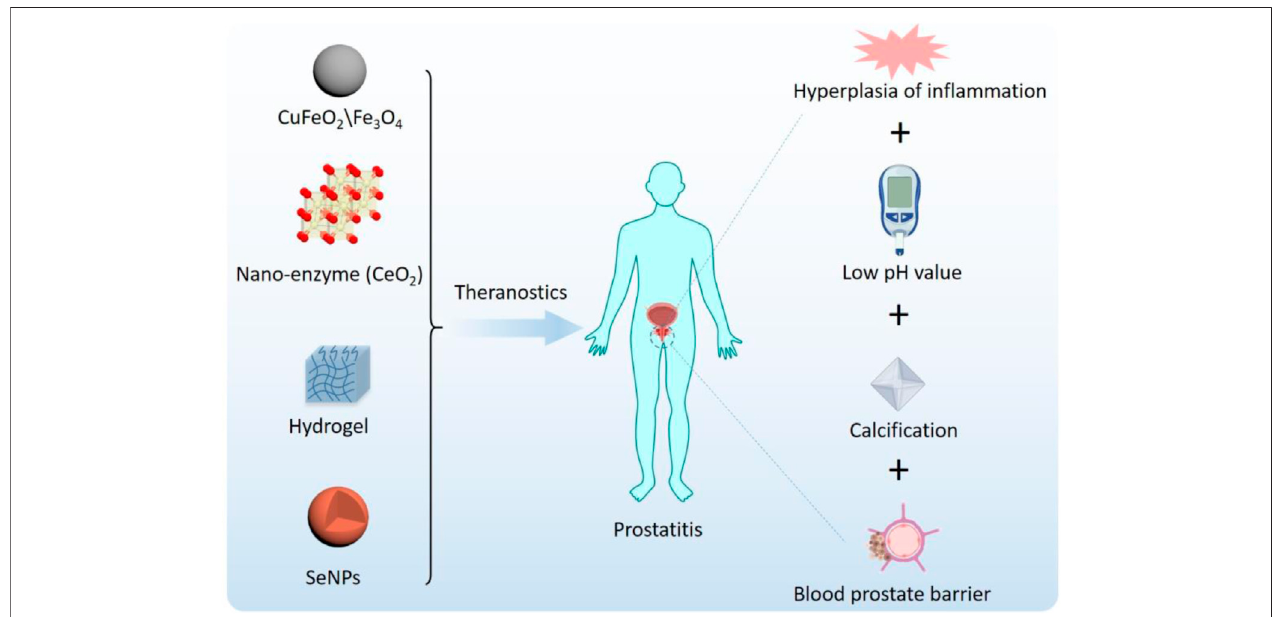
FIGURE 2 | Smart nanoparticles for